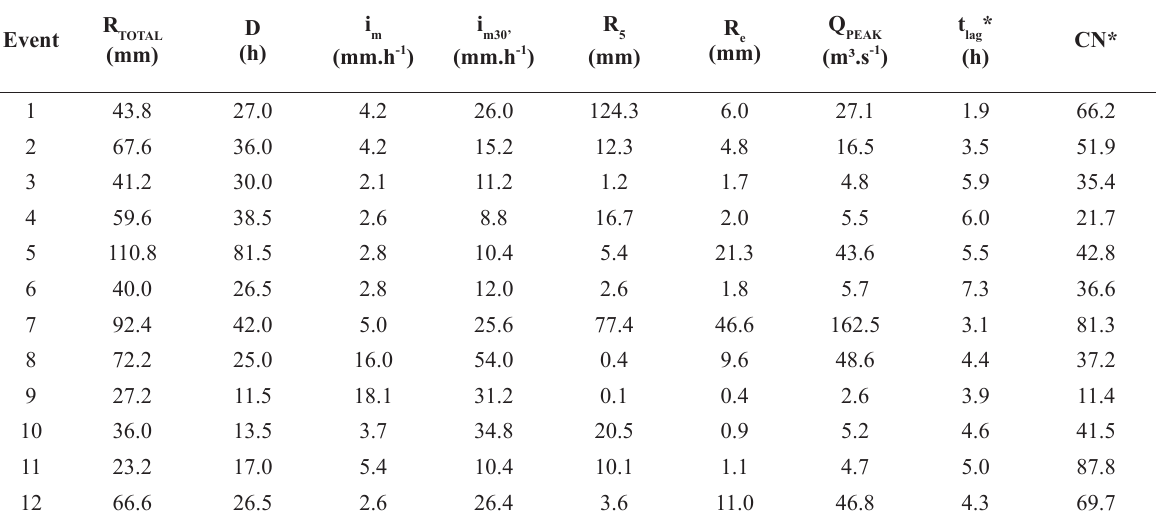
Characterization of the rainfall-runoff events used for flood modeling in the CRW, describing the rainfall (R duration of event (D), mean rainfall intensity (i (R ), effective rainfall (R 5